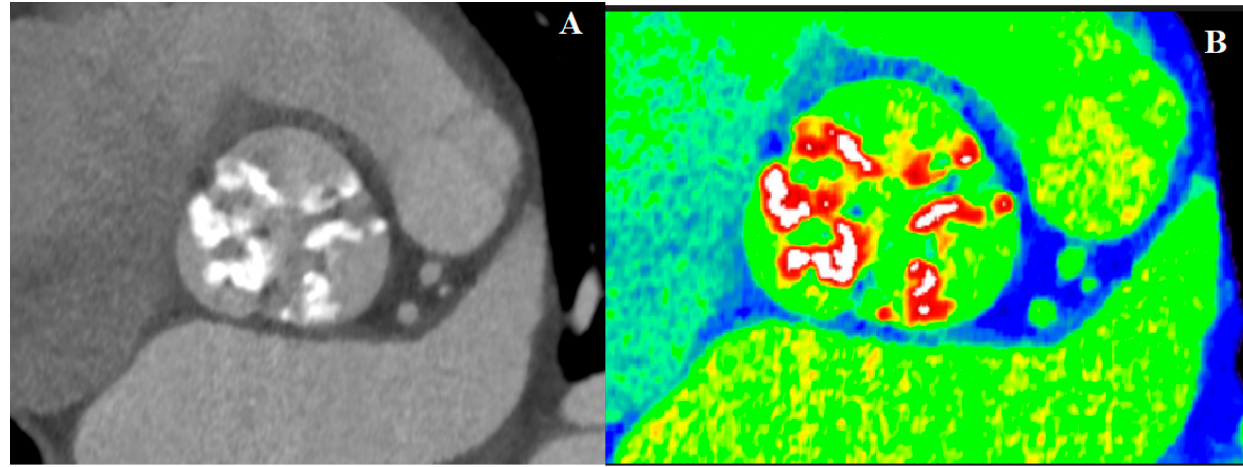
Figure 4. Measurement of aortic valve calcifications on representative images. ( A ): Low dose chest CT scan image focused on the aortic valve of an 86 ‐ year ‐ old woman with low ‐ flow low ‐ gradient aortic stenosis and 9000 Agatston score. ( B ): In white color number in Hounsfield Units (HU) to quantify aortic valvular calcium on contrast ‐ enhanced scans. Here, equal to 1000 HU. Courtesy of Marianna Adamo.